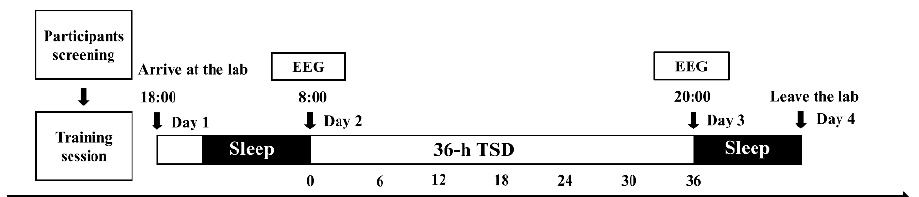
Figure 2. A flowchart of the four-day sleep deprivation experiment. Participants entered the labora- tory at 18:00 on the first day of the experiment and slept in the laboratory that night under normal conditions. On the second day at 08:00, the first behavioral and EEG data acquisition of the stop-signal task was performed on the participants before the official start of the sleep deprivation ex- periment (SD: 0 h). On the third day at 20:00, the stop-signal task and sleep deprivation ended (SD: 36 h) with the acquisition of the second behavioral and EEG data. Participants remained in the la- boratory for a recovery sleep on the evening of the third day and left the laboratory on the morning of the fourth day. 2.4. Data Acquisition and Analysis 2.4.1. Behavioral Data Acquisition We converted the E-Prime data file to Excel format to extract the behavioral indica- tors we were concerned about. (1) Go RT: Time to correct response to the go trials. (2) Go Accuracy: % correct responses in go trials. (3) Mean SSD: The average SSD of all stop trials. (4) Quantile RT (QRT): The response times of all the correct responses of the go trials were sorted in ascending order, and the go RT at the percentage of inhibition failure was taken as the QRT. (5) SSRT: QRT-mean SSD. (6) Stop Accuracy: % correct inhibited responses in stop trials. In the behavioral data analysis, we focused on four behavioral indicators: Go RT, Go Accuracy, SSRT, and Stop Accuracy. 2.4.2. ERP Data Acquisition ERP data were acquired using a 32-channel amplifier and recorded online by Neu- roscan software with a sampling rate of 1000 Hz. Electrodes were arranged in accordance with the extended international 10–20 system. FCz lies at the midpoint of the line connect- ing Fz and Cz. The data were analyzed offline using the EEGLAB and ERPLAB plug-ins, using average re-reference and band-pass filtering from 0.1 to 30 Hz after manually clip- ping the bad segments. The 50 Hz mains electricity was removed, and the eye-electricity artifacts were corrected using independent component analysis (ICA), and the artifact tri- als with amplitudes exceeding ±100 μV were removed from the artifact correction. Analysis of N2 and P3 Amplitudes The trials successfully inhibited in the stop trial were selected for inclusion in the ERP analysis and considering that the stop signal was preceded by the go signal, the mean values of 1100–900 ms before the presentation of the stop signal were selected for baseline correction. The average values of Fz, FCz, and Cz electrodes were selected to calculate the average amplitude of the N2 component (190–250 ms); the average values of F3, F4, Fz, FCz, and Cz electrodes were selected to calculate the average amplitude of the P3 compo- nent (250–400 ms).